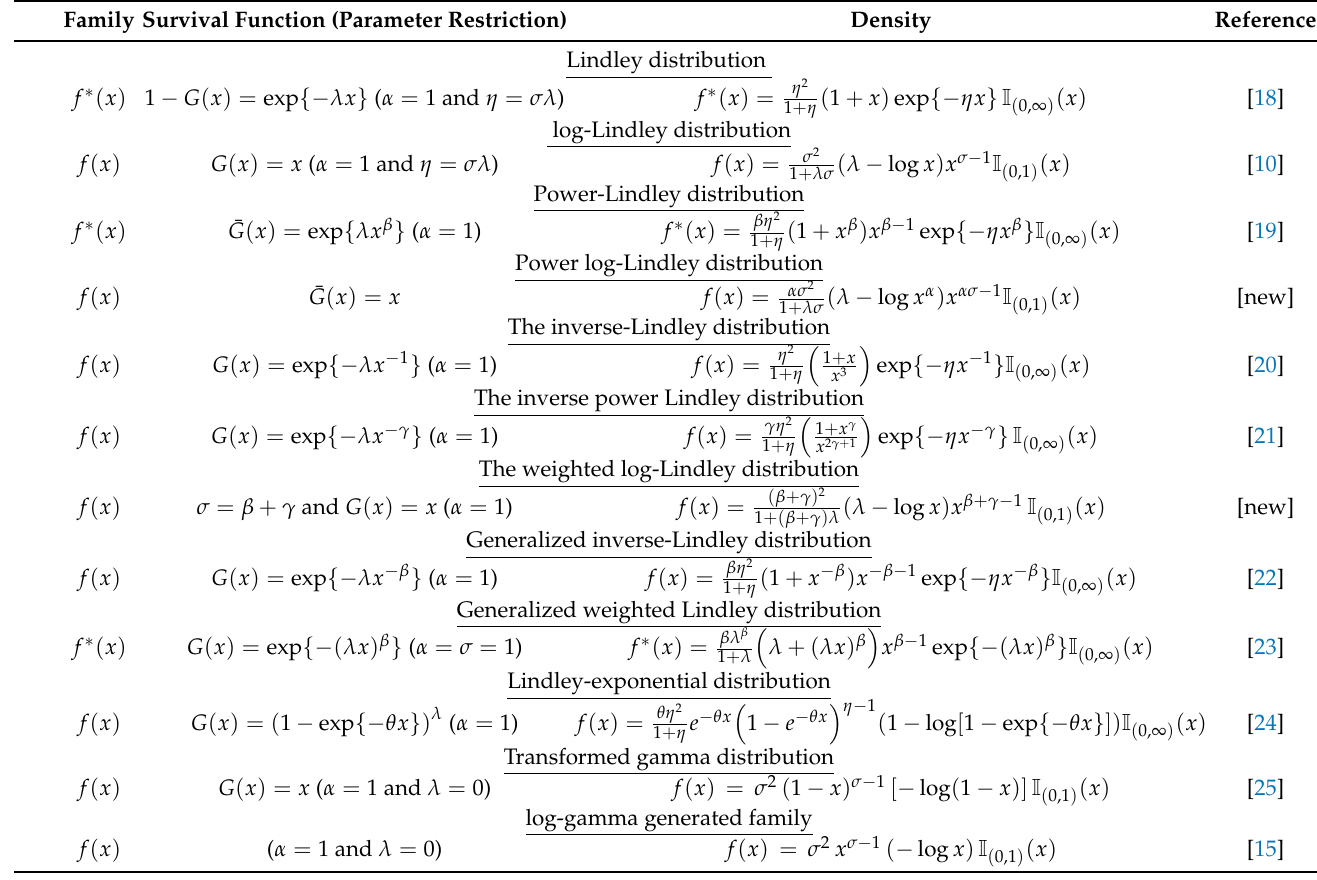
Table 1. Particular and special cases defined from the proposed families. I A ( x ) means the indicator function in set A . Family Survival Function (Parameter